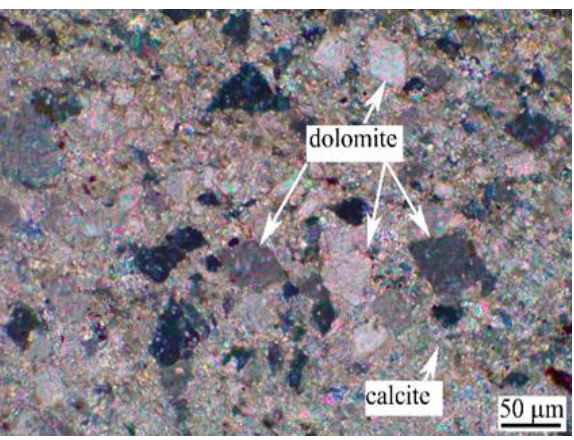
Figure 3. Petrographic micrographs of dolomitic limestone S1# from Baofuling, China.